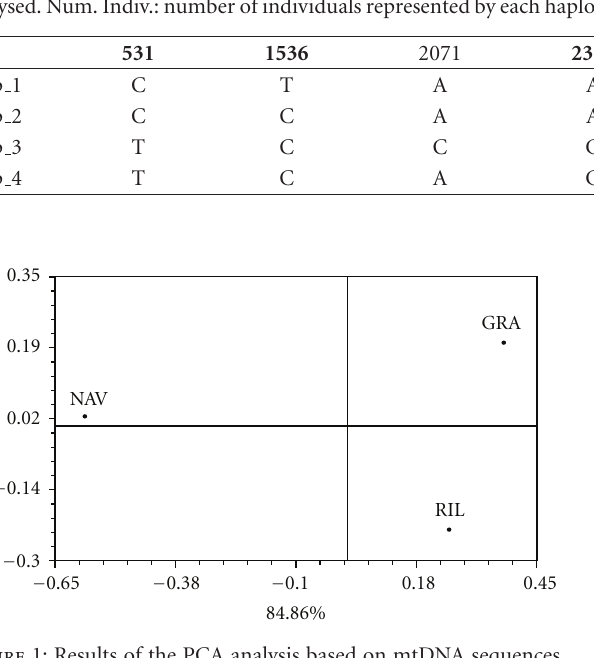
Table 2: Haplotypes found in A. italicus Spanish populations. Columns 2–5 refer to position of the SNP in the 2501 nt sequence. Bold numbers—first line—: SNP informative under parsimony. Freq: frequency in percentage of each haplotype in the total of individuals